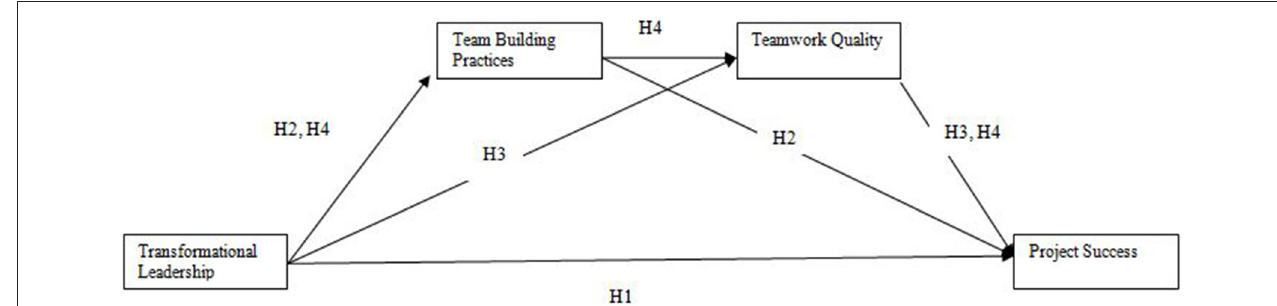
FIGURE 1 | The proposed